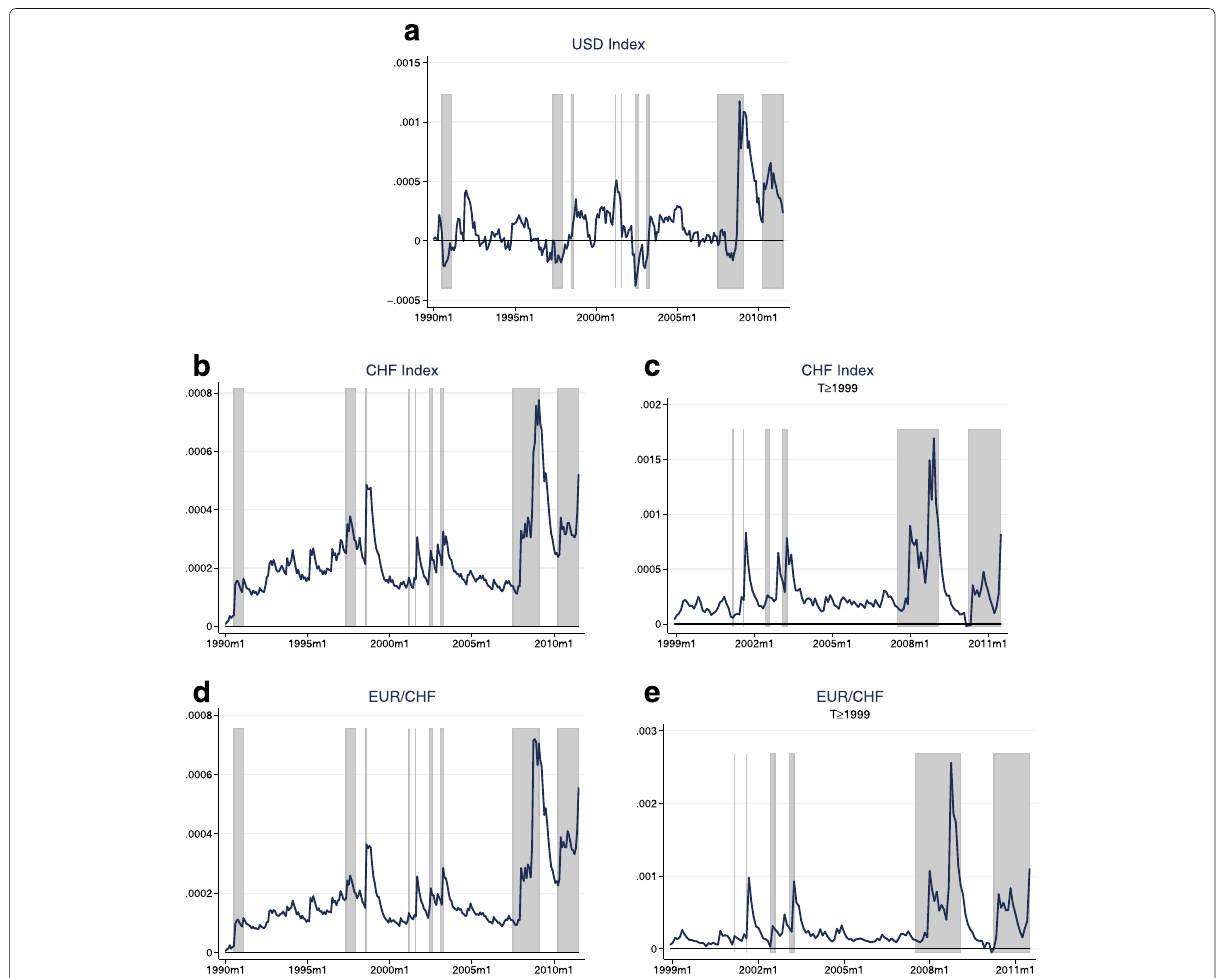
Fig. 7 ( a - e ) GARCH results—conditional covariance estimates. Notes: The estimates of the conditional covariance correspond to the fitted values of the DCC MGARCH-in-mean model for the case of no time variation in the price of risk. For details see section D.1.1 in the Additional file 1